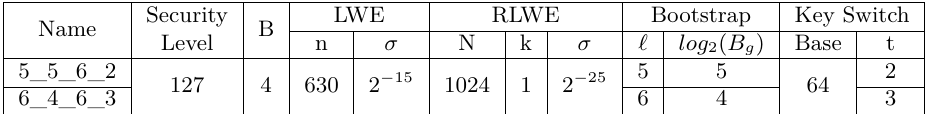
Table 2: Sets of parameters used to evaluate the performance of our implementations.